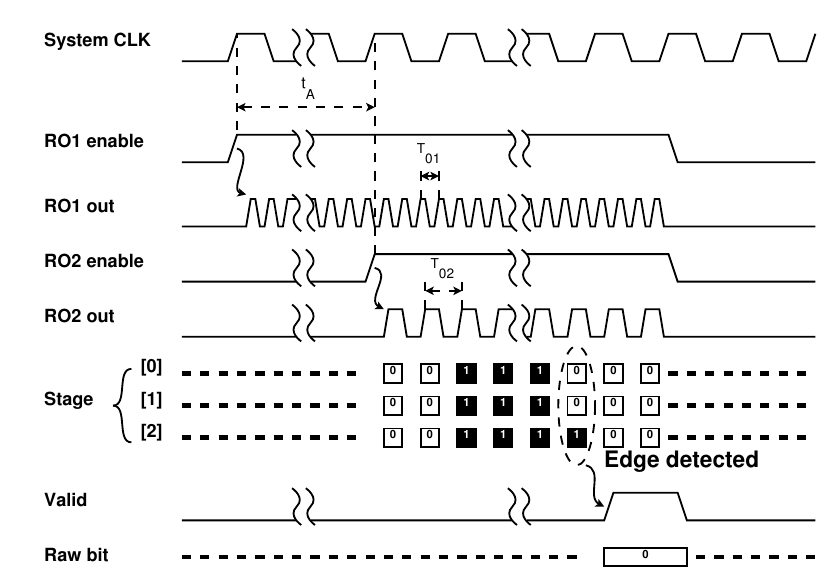
Figure 5: Timing diagrams of repetitive